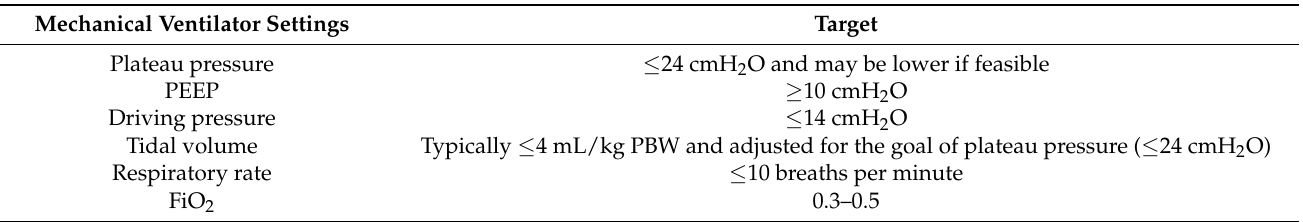
Table 3. Summary of recommended ventilation settings during the initial phase of ECMO for patients with ARDS. Mechanical Ventilator